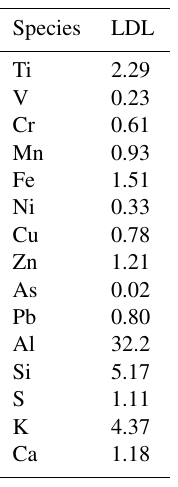
Table 2. Lower detection limits (LDLs, ngm − 3 ) for metals mea- sured by the PX-375 during 26 August–2 September 2015. Con- centrations less than the LDLs were excluded from